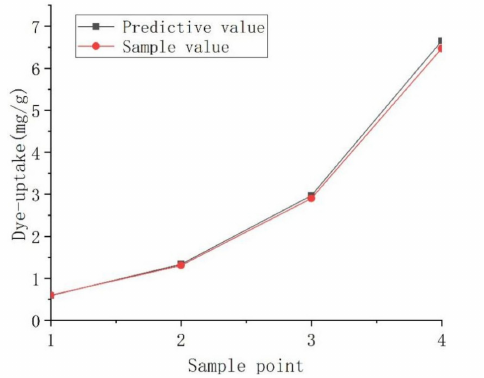
Figure 10. Verification results of prediction performance of BPNN model.